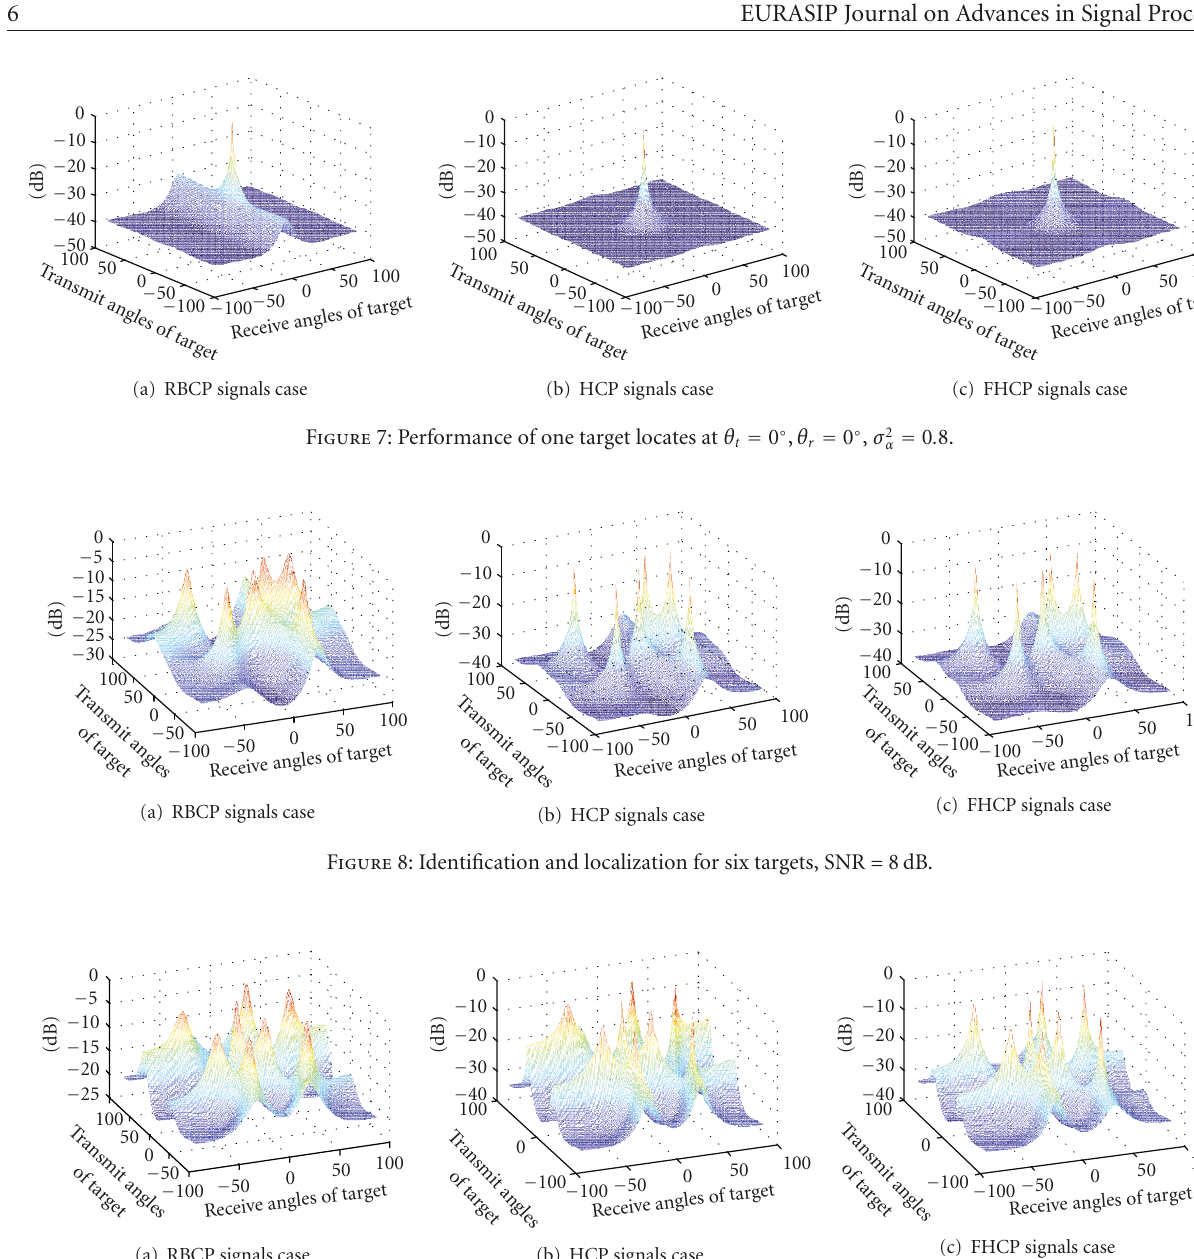
Figure 9: Identification and localization for six targets, SNR =